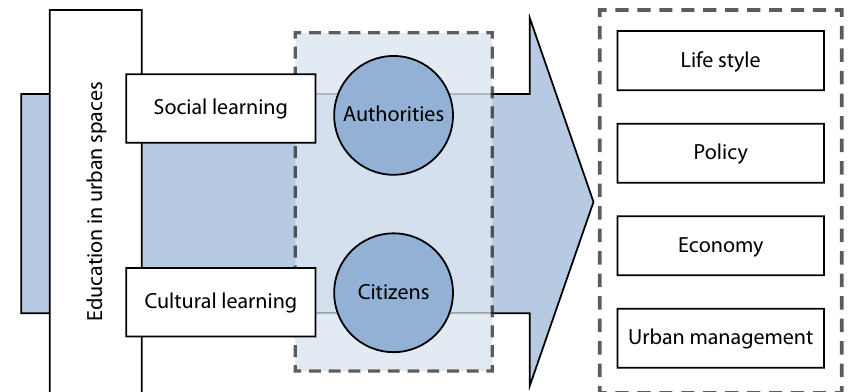
fig. 3. Impact of learning in